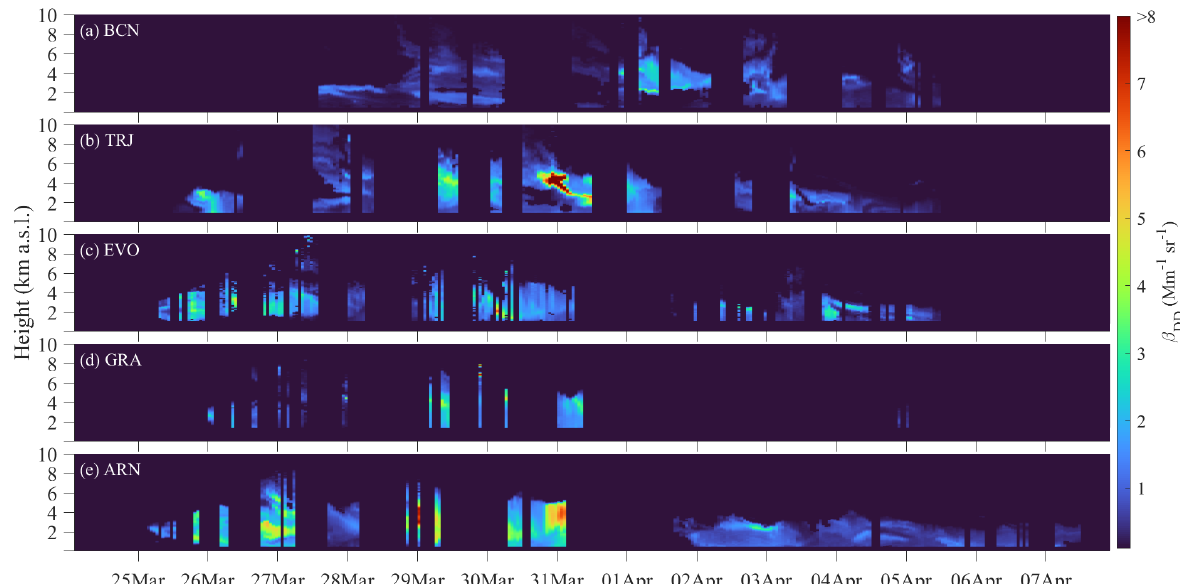
Figure 3. Temporal evolution of the total dust backscatter coefficient ( β DD , Mm − 1 sr − 1 ) at the five Iberian lidar stations (from NE to SW, by decreasing latitude): (a) BCN, (b) TRJ, (c) EVO, (d) GRA, and (e) ARN. Profile gaps correspond to either no possible inversion or no lidar